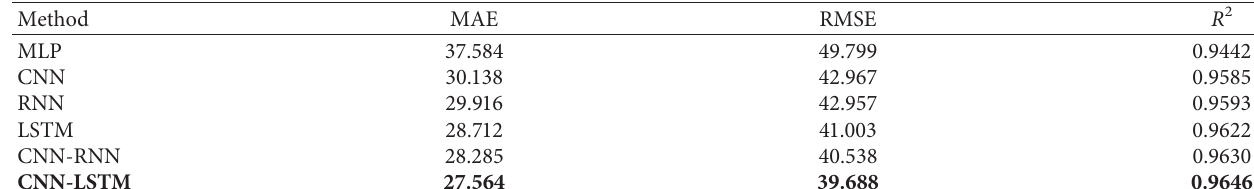
Table 3: Comparison of nine methods evaluation indexes.